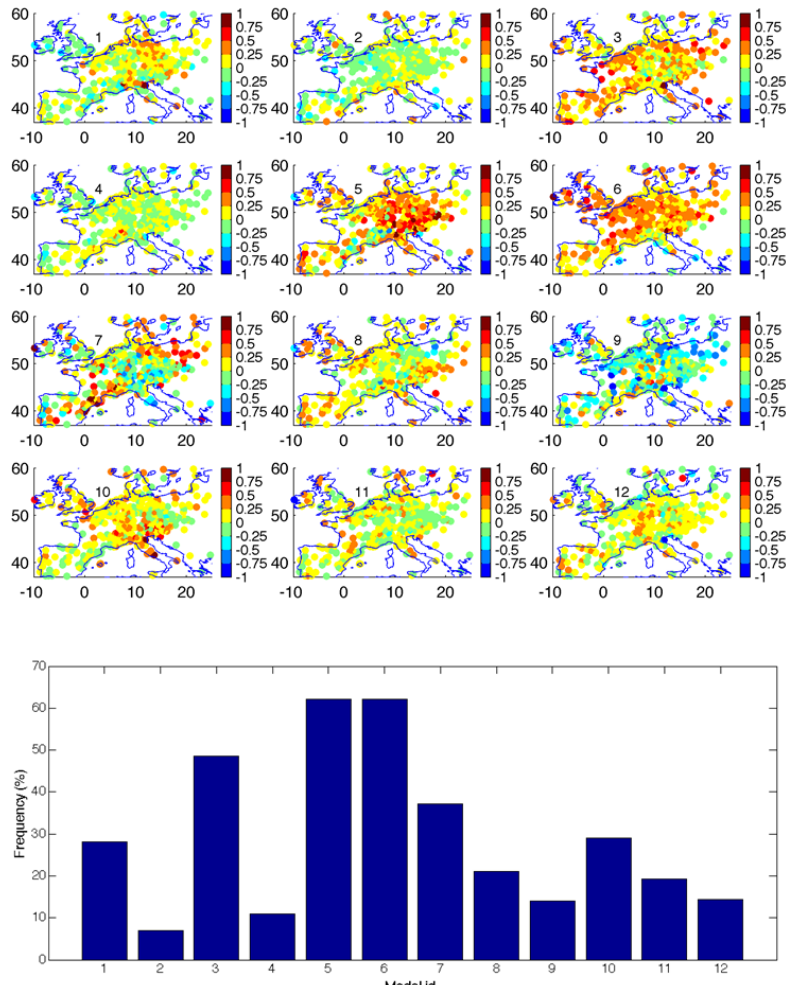
Figure 8. Ozone spatial weights (mmeW) calculated for each model (1–12) for JJA (1 segment) at the observed rural sites (segment de-bias) and aggregated frequency of model use in mmeS, from all the 451 stations for the test data